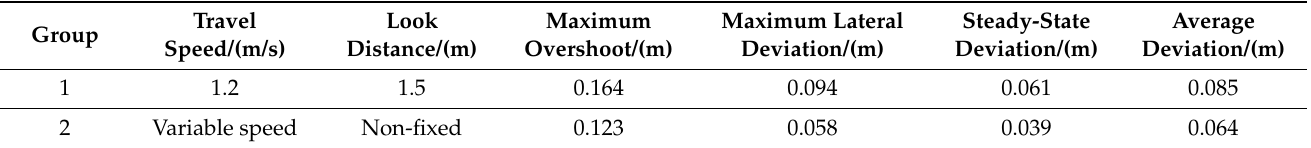
Figure 19. Lateral deviation. Table 3. Comparison table of lateral deviation data.